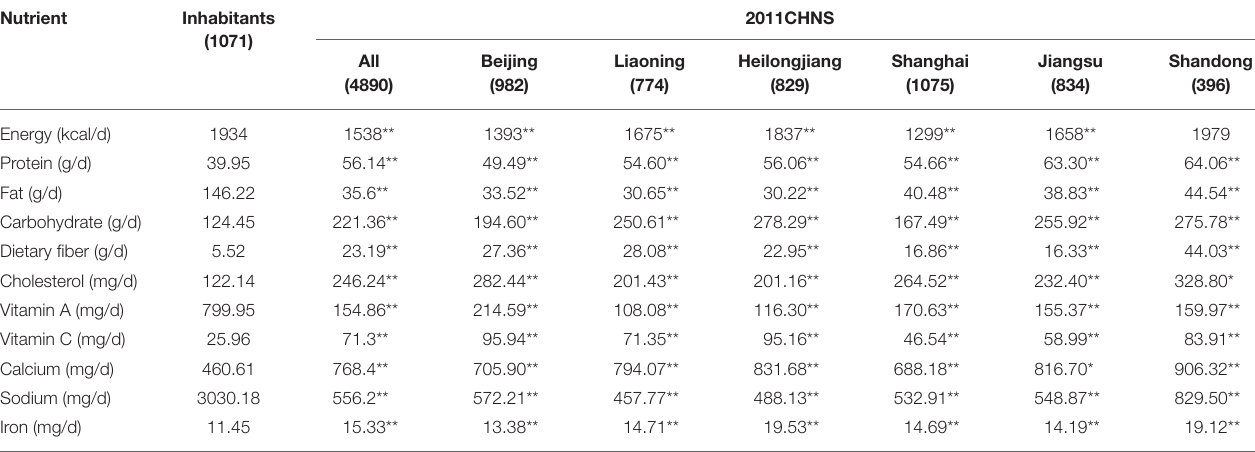
TABLE 4 | Daily nutrient intakes of inhabitants in high altitude compared with 2011 China Health and Nutrition Survey (2011CHNS). Nutrient